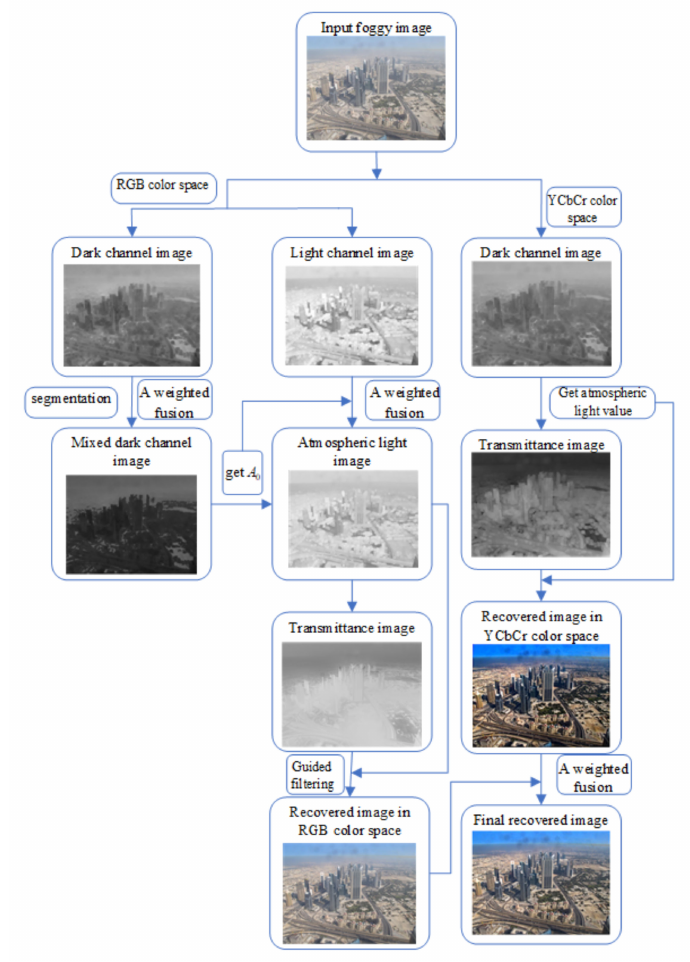
Figure 11. Image of the defogging process.